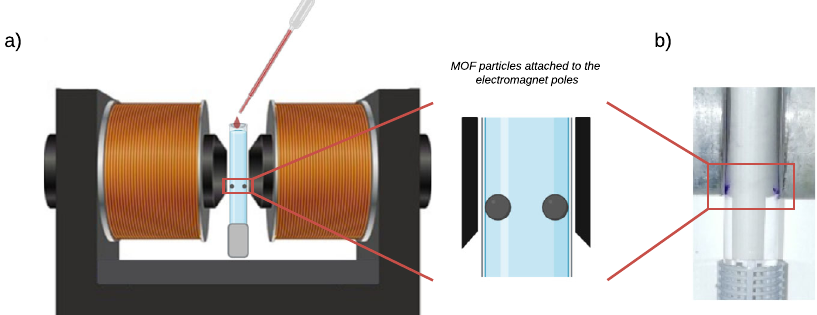
Fig. 2 Experimental set-up for magnetic sustentation experiment. a Scheme of the experimental set-up for magnetic sustentation experiment and b an example of ZIF-67(Co) particles attached to the bottom part of the electromagnet